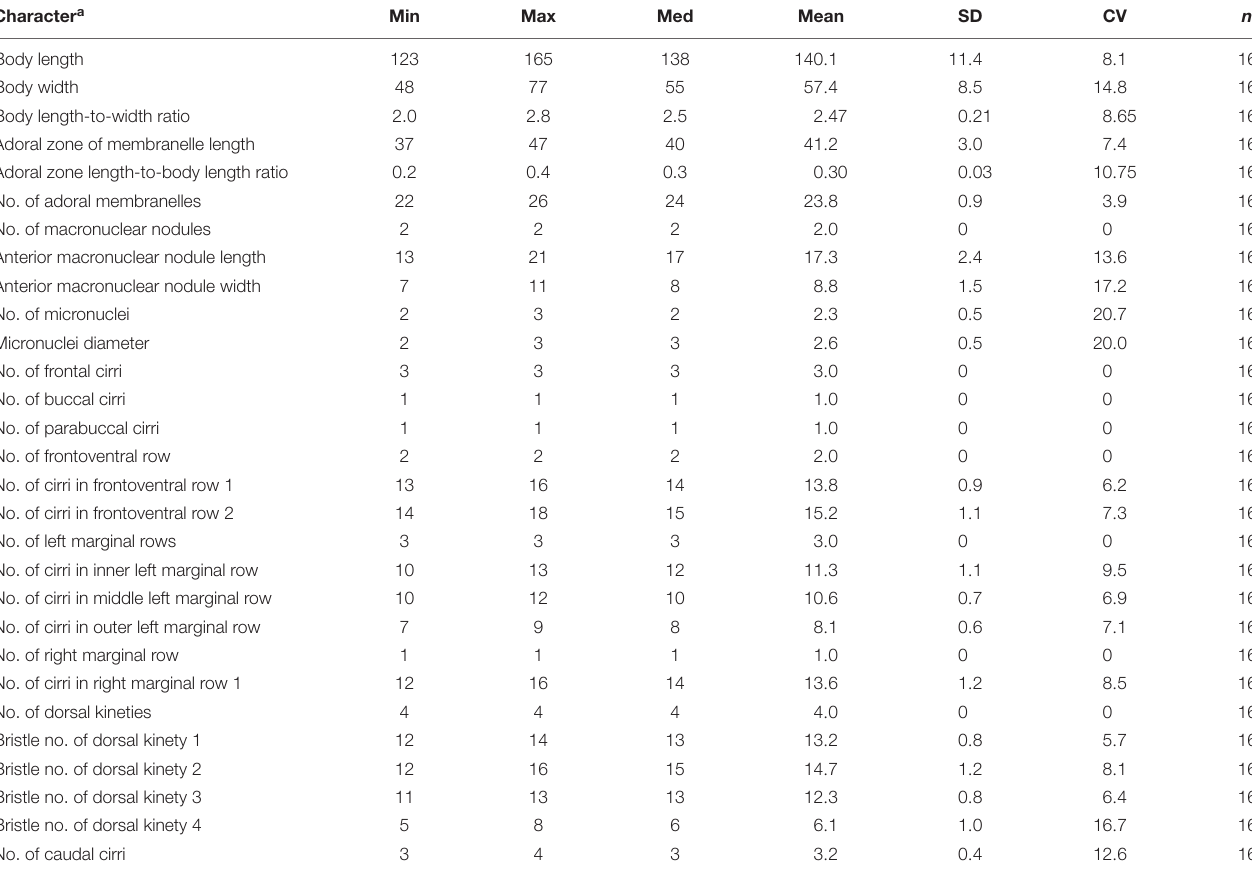
TABLE 1 | Morphometric characterization of the Chinese population of Pseudosincirra longicirrata nov. gen. and nov.